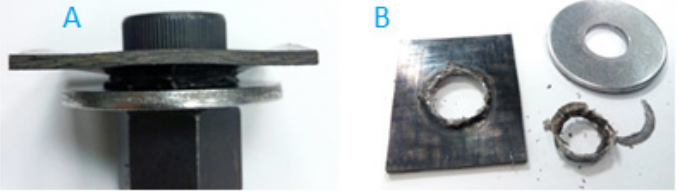
Figure 4. Specimen PA6 FG45 with no washer: ( A ) Ripple failure (M A max = 120 Nm). ( B ) Total collapse (M A = 140 Nm).